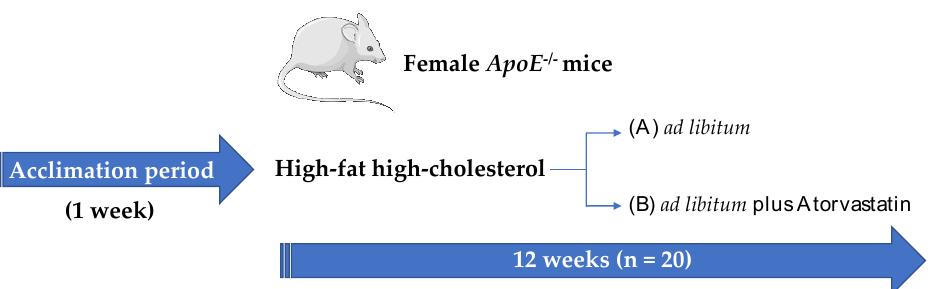
Figure 9. All animal procedures performed conform to the guidelines from directive 2010/63/EU of the European Parliament on the protection of animals and were approved by the Ethical Committee (authorization number 476/2020-PR). At sacrifice, liver, visceral adipose tissues, skeletal muscles, spleen, and kidneys were collected and weighted.